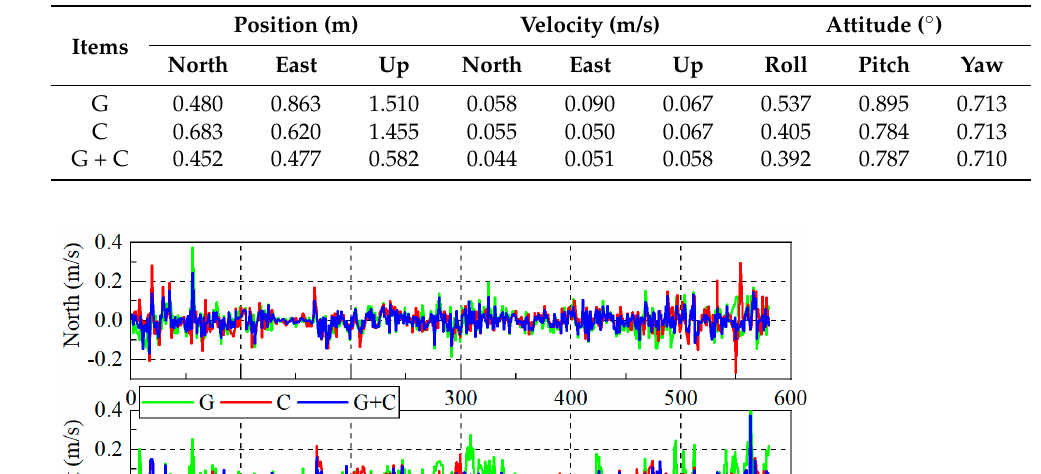
Table 3. RMS of position, velocity, and attitude error of dual-antenna GNSS/MIMU tightly coupled integration using the SVD-RACKF in the case of single GPS (G), single BDS (C), and their combination (G + C).